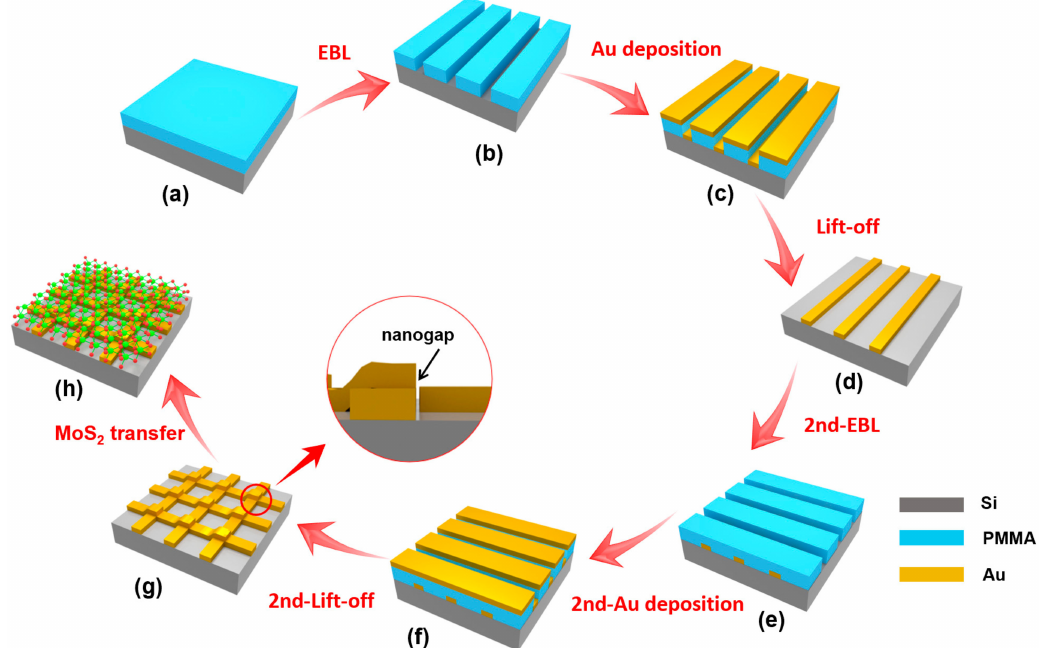
Figure 1. Schematic fabrication procedures of the MoS 2 / Au nanogap hybrid. ( a ) Substrate coated with polymethyl methacrylate (PMMA). ( b ) Nanotranches formed after the first E-beam lithography (EBL) process. ( c ) First Au deposition process. ( d ) Au nanostrips obtained after lift-o ff process. ( e ) Nanotrenches formed after the second EBL process. ( f ) The second Au shadow deposition process. ( g ) Nanogaps obtained by crossover of nanostrips. ( h ) Hybrid structure formed after MoS 2